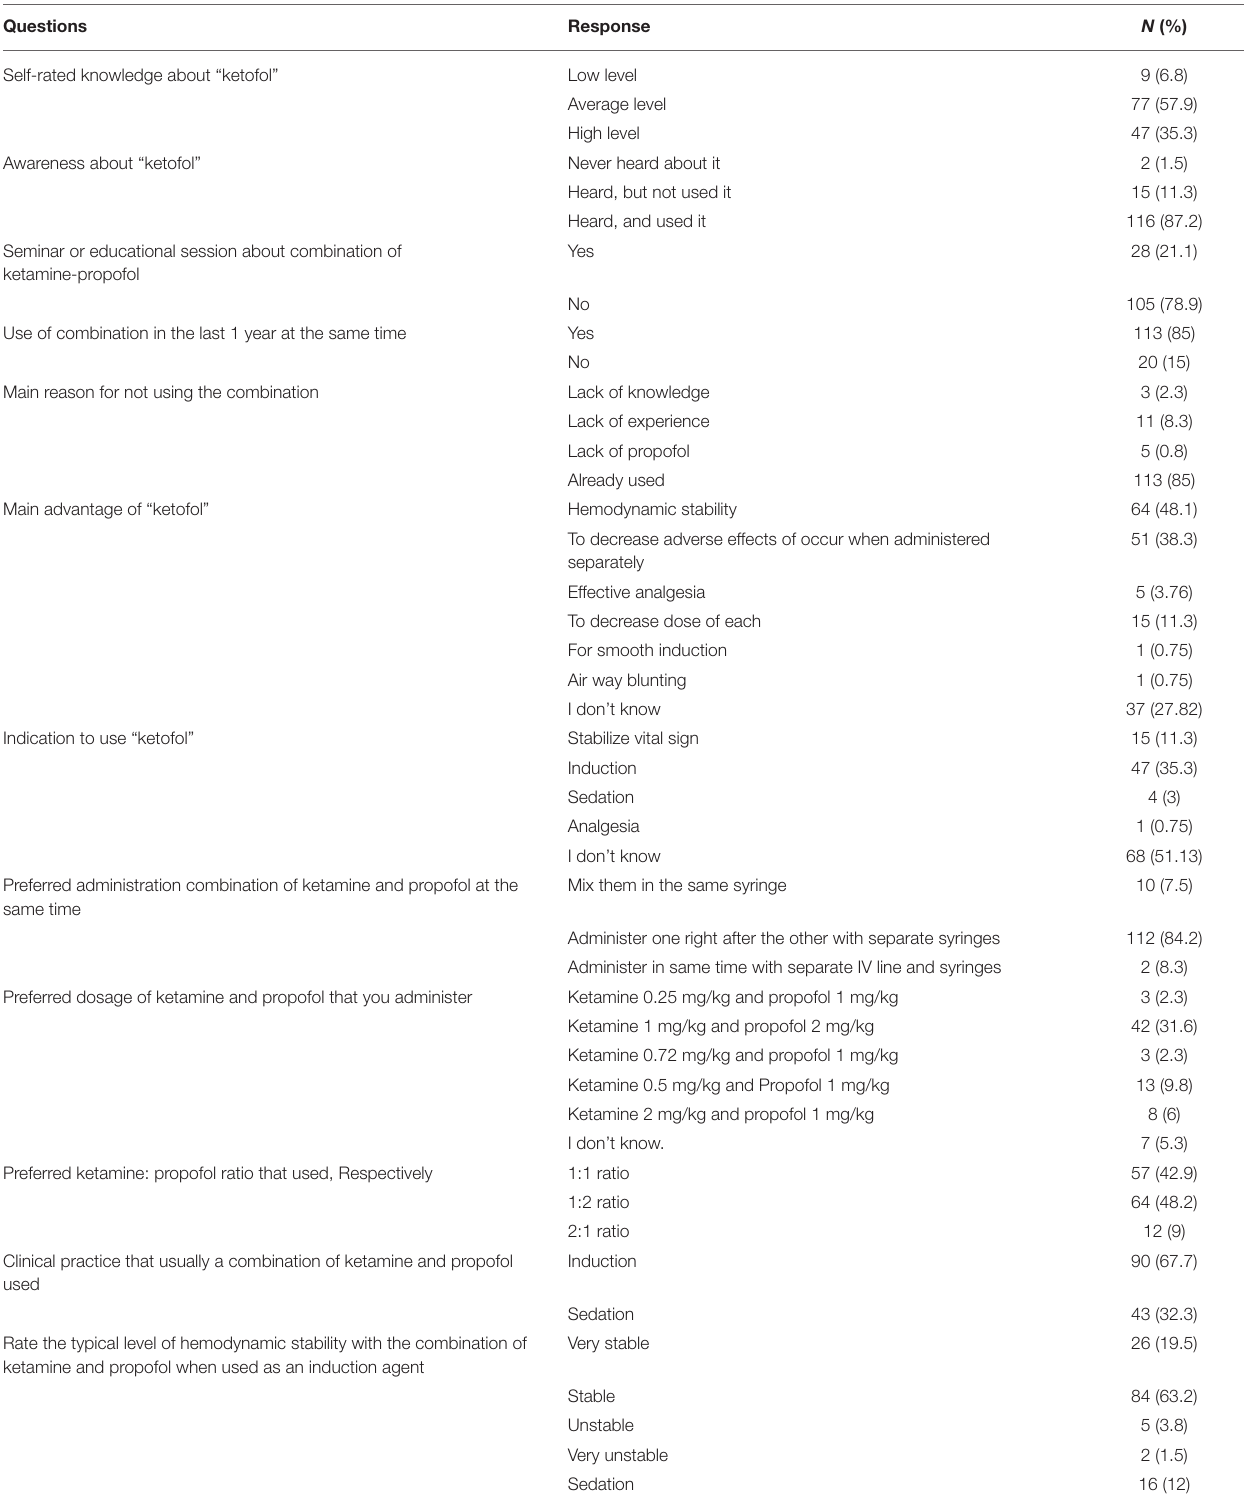
TABLE 2 | Knowledge and practice of ketamine-propofol combination (ketofol) among anesthesia providers at the UOGCSH, Gondar, Ethiopia, 2019.